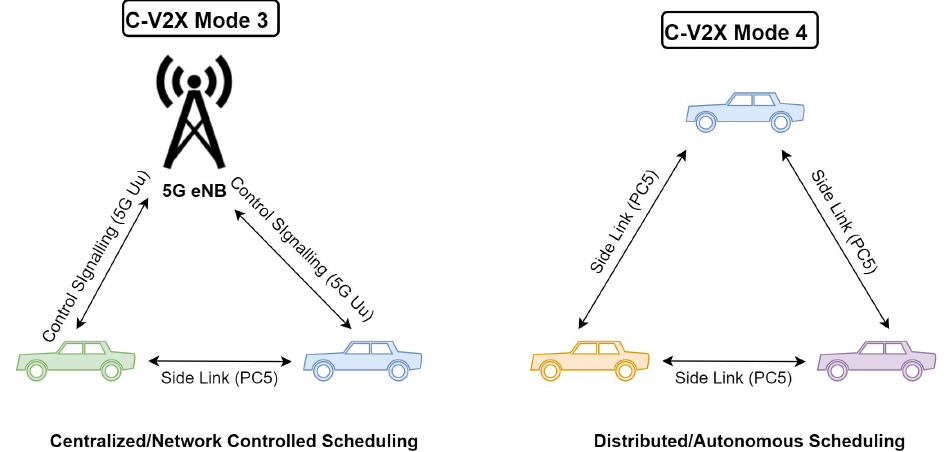
Figure 3. Transmission modes 3 and 4 of Cellular V2X (C-V2X)